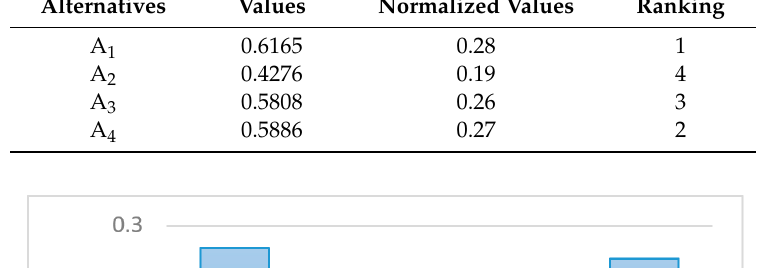
Table 25. The final result of the judgments matrix using the AHP method. Alternatives Values Normalized Values